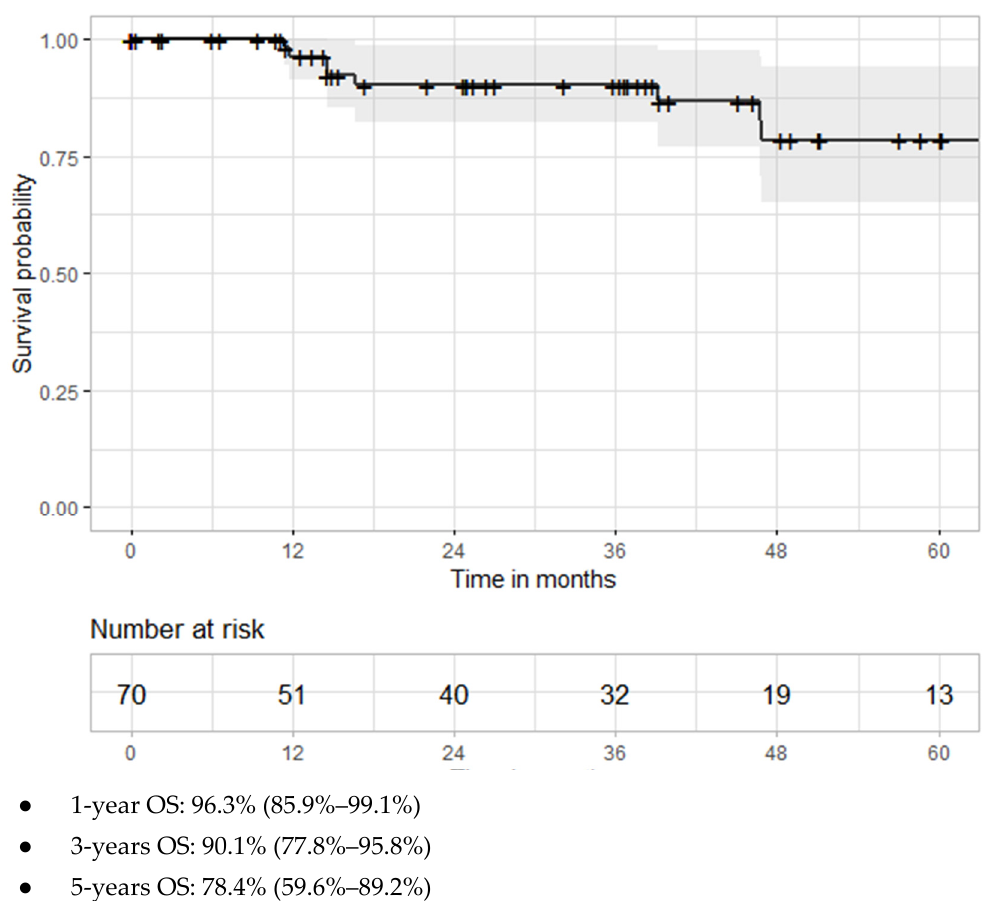
Figure 5. Kaplan Meier curve of overall survival for patients with biopsy-proven malignant lesions treated with percuta- neous cryoablation.